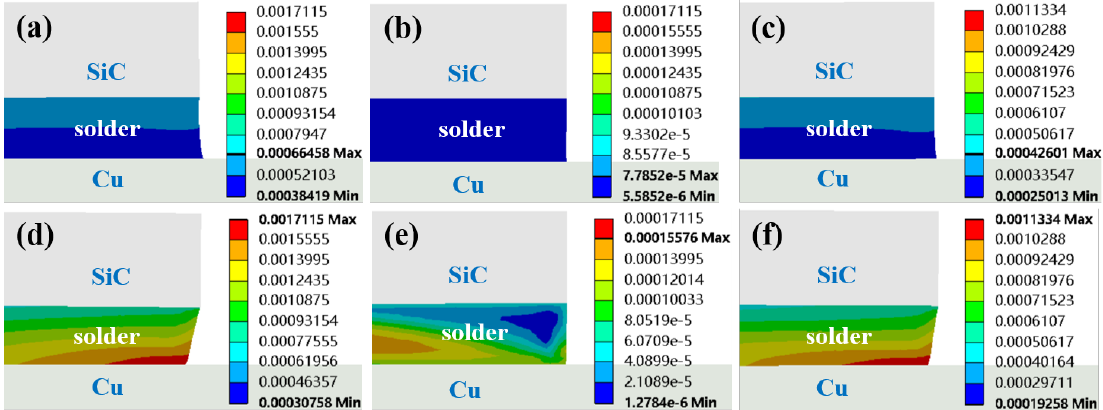
Figure 6. The deformation contour plot corresponding to the points ( a ) A, ( b ) B and ( c ) C in the stress recovery peak under the fixed constraint, and the ( d – f ) corresponding deformation contour plots under the non-fixed constraint.